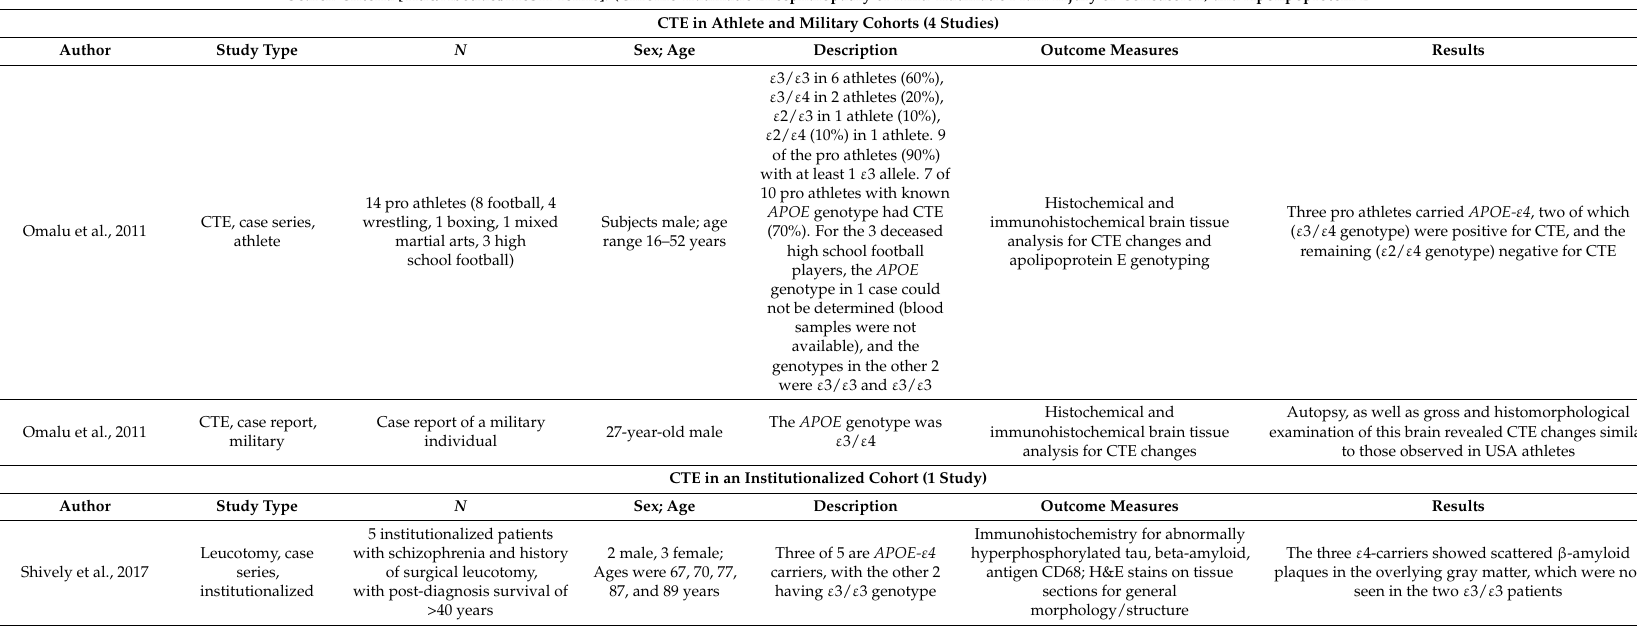
Search Criteria [Title/Abstract/MeSH Terms]: (Chronic Traumatic Encephalopathy or Mild Traumatic Brain Injury or Concussion) and Apolipoprotein